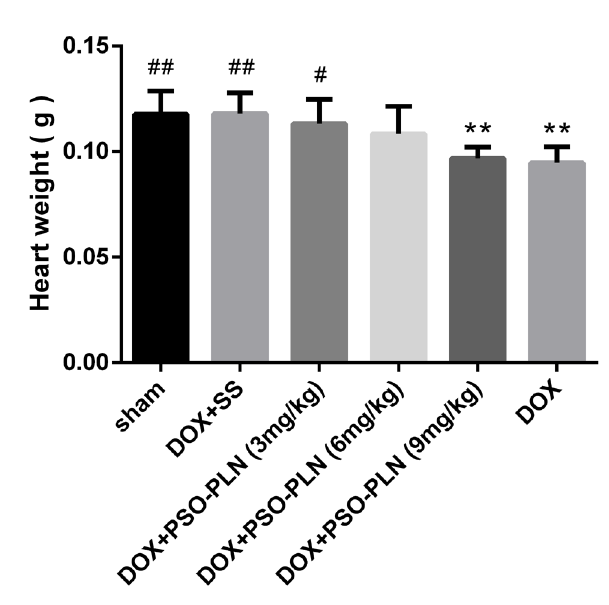
FIGURE 3 - Change in the heart weight over 21 days in